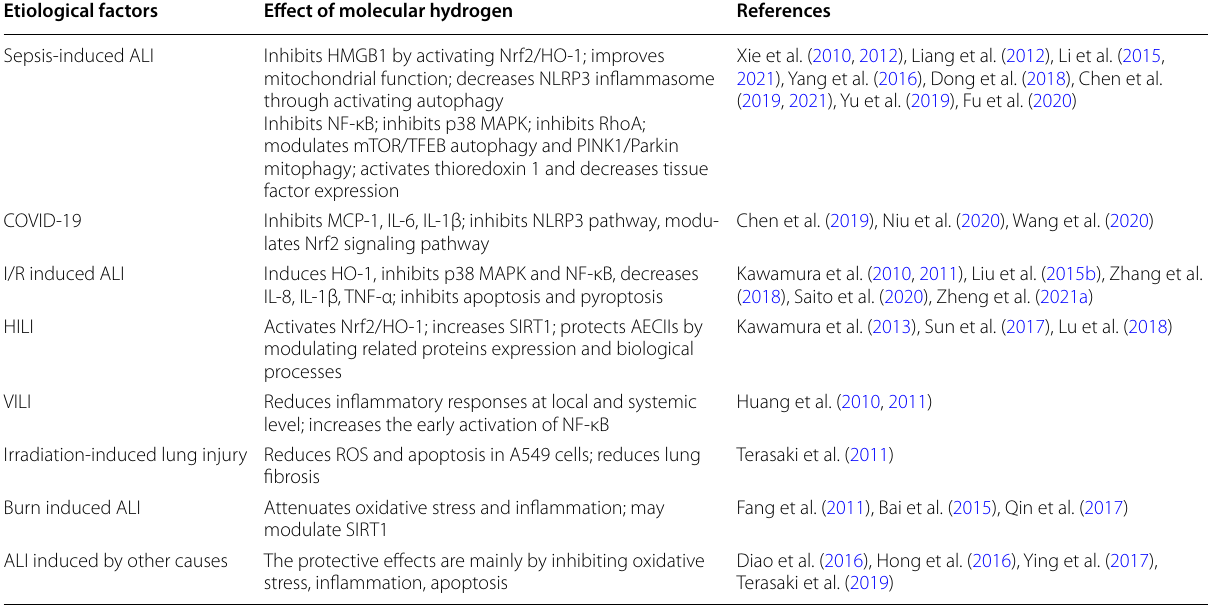
Table 2 Application of molecular hydrogen in ALI caused by various etiological factors Etiological factors Effect of molecular